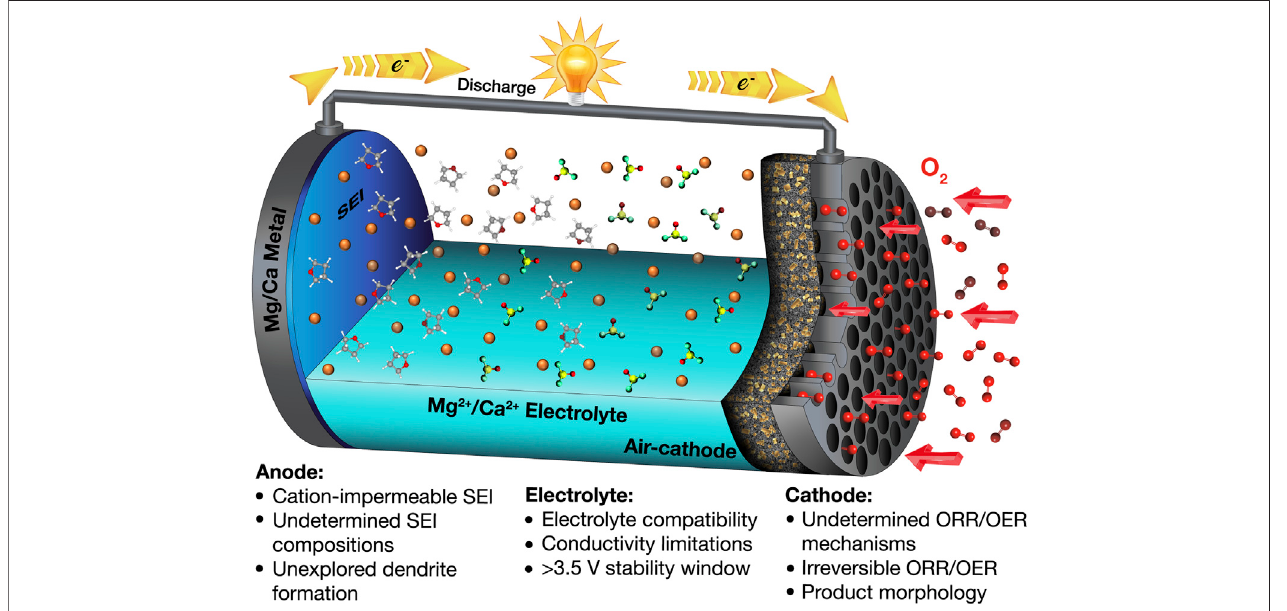
FIGURE 1 | Schematic of a discharging Mg/Ca-O 2 cell and the challenges for nonaqueous alkaline-earth metal-air batteries.